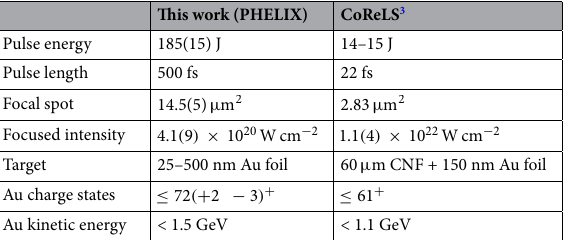
Table 1. Comparison of experimental parameters of this work, performed at the PHELIX laser, with the experiment at CoReLS from reference 3 .